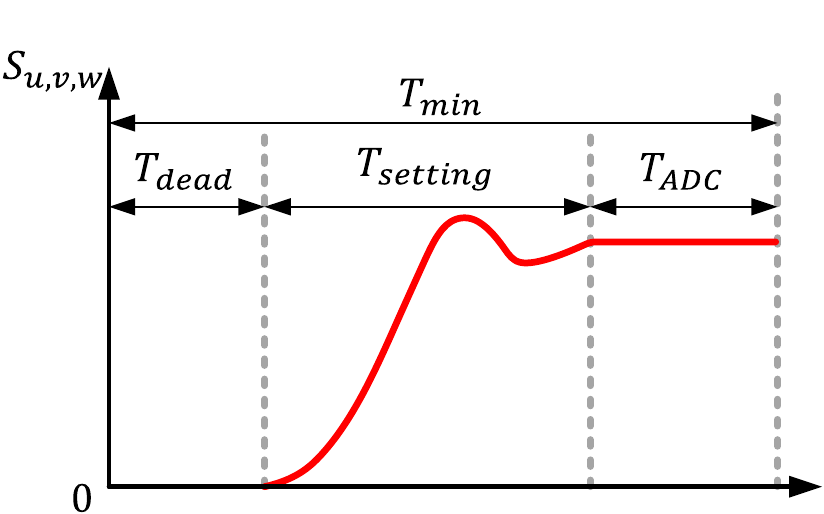
Figure 5. Configuration of the minimum time ( T min ) needed to detect current.